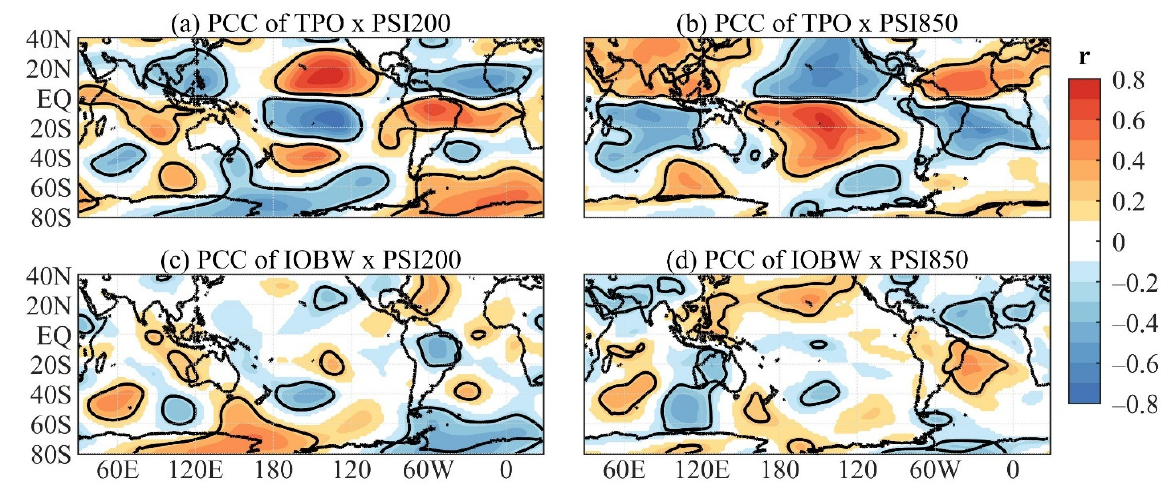
Figure 9. Partial correlations for the asymmetric streamfunction during summer of the ( a ) TPO and PSI200; ( b ) TPO and PSI850; ( c ) IOBW and PSI200; ( d ) IOBW and PSI850. Continuous line encompasses significant correlations at a 95% confidence level using Student’s t ‐ test.